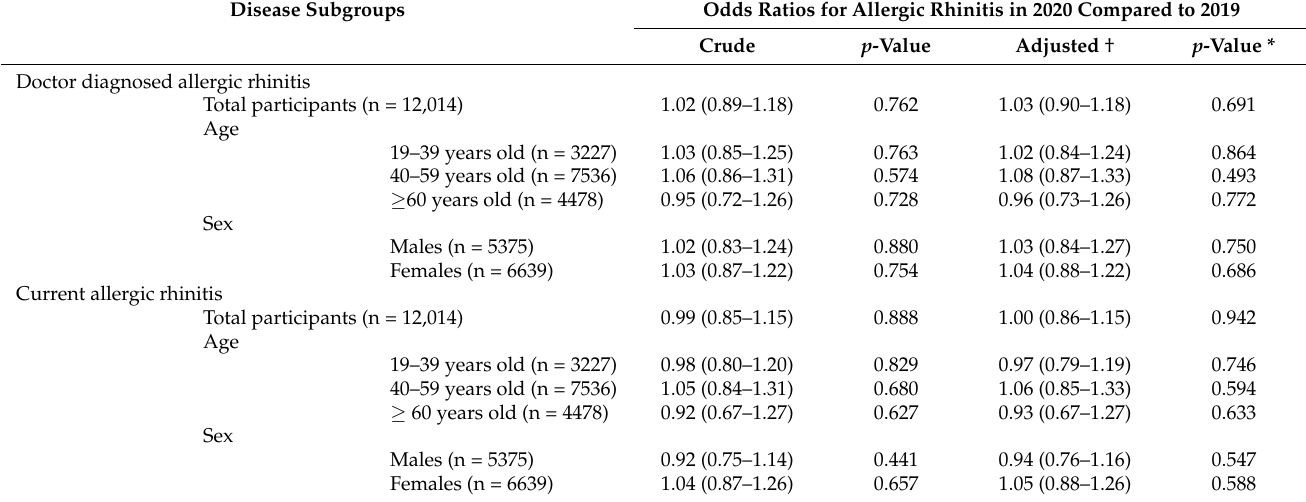
Table 4. Odds ratios (95% confidence intervals) for allergic rhinitis (doctor diagnosed allergic rhinitis, current allergic rhinitis) in 2020 compared to 2019 with subgroup analyses according to age and sex. Disease Subgroups Odds Ratios for Allergic Rhinitis in 2020 Compared to 2019 Crude p